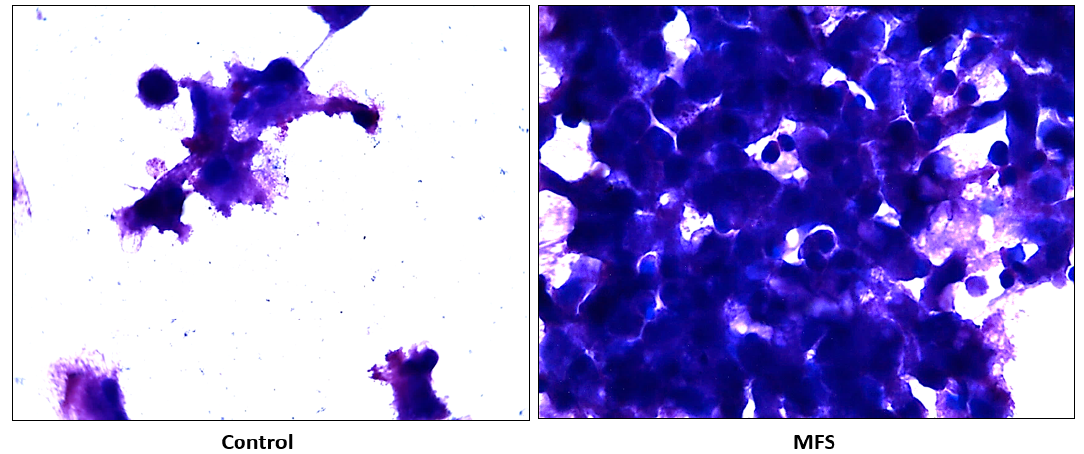
Figure 6. Hematoxylin and Eosin staining of untreated and MFS-treated human granulomas from healthy subjects. Microscopy work was done with a light microscope at 100 × magnification under oil immersion.